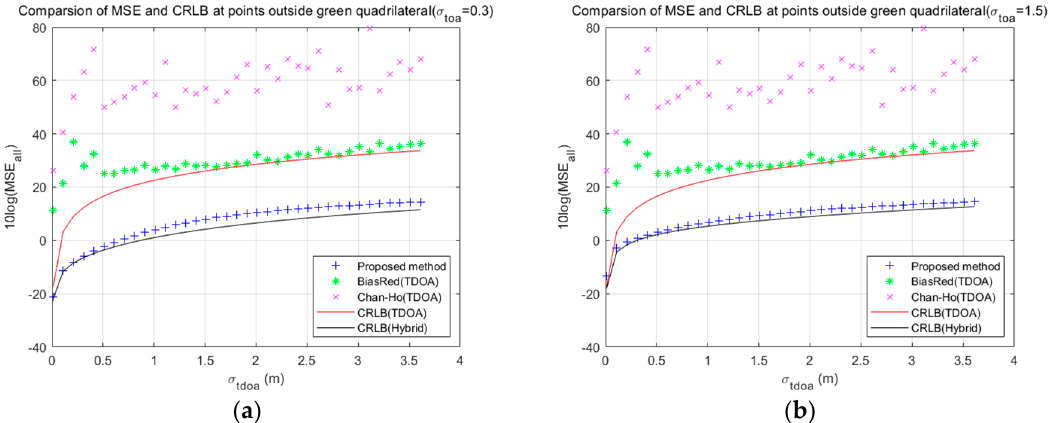
Figure 14. Accuracy of different positioning method at points outside green quadrilateral; ( a ) positioning error MSE when the standard deviation of TOA ranging error is 0.3 m; ( b ) positioning error MSE when the standard deviation of TOA ranging error is 1.5 m.